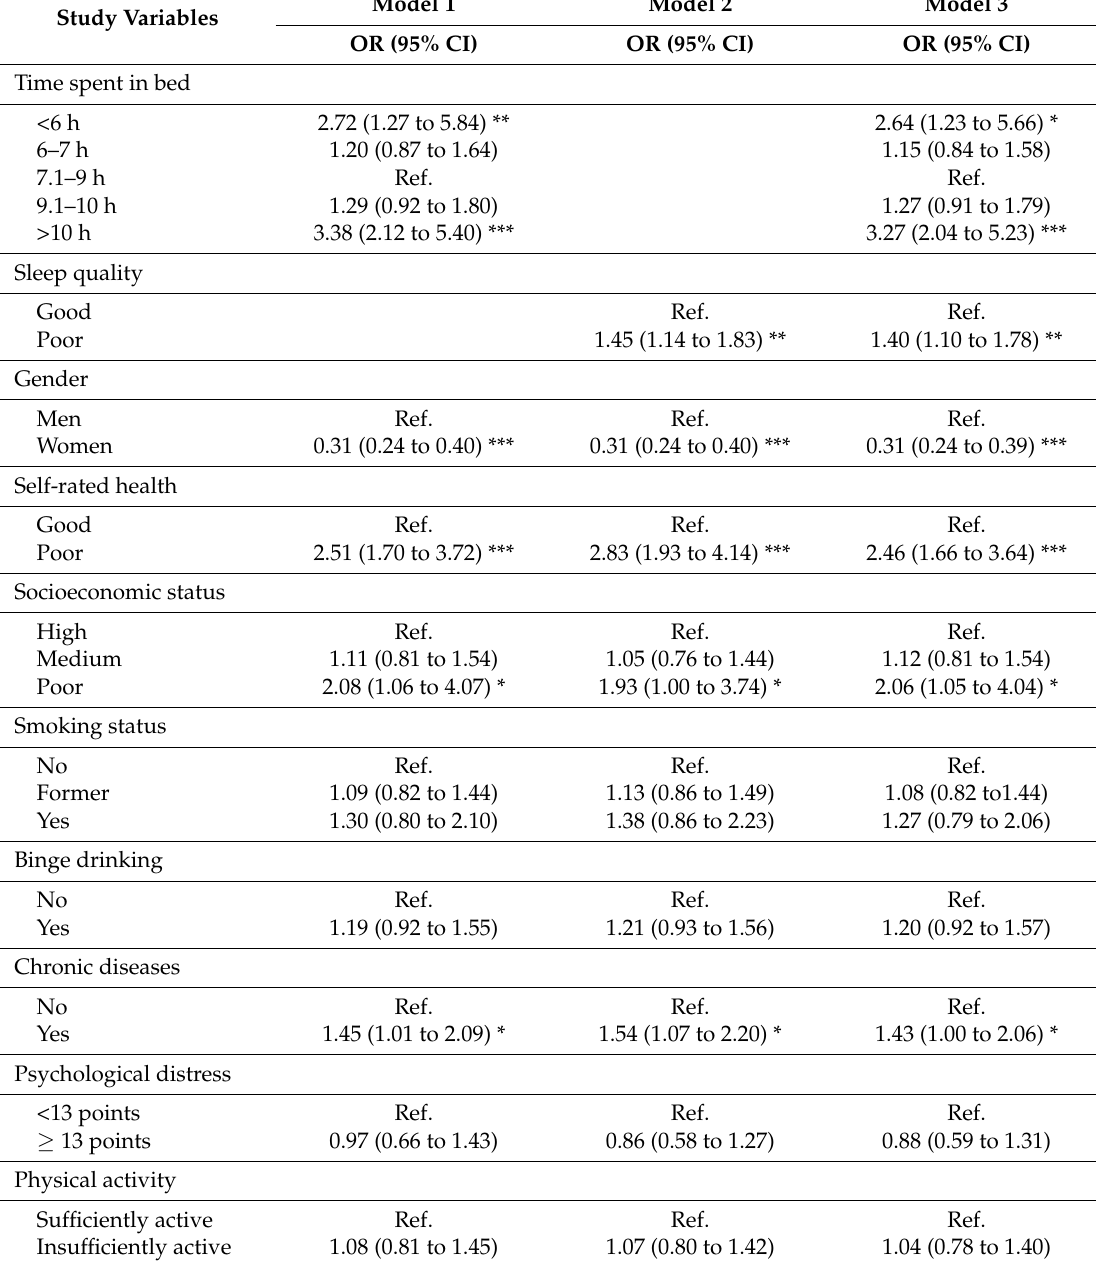
Table 2. Separate and simultaneous associations between time spent in bed and sleep quality with overweight/obesity status of the study participants, Croatia